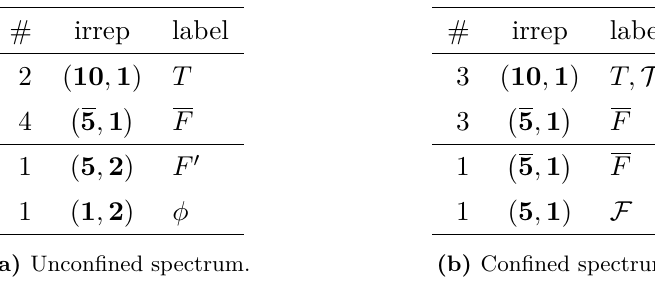
Table 2. Summary of the SU(5) × SU(2) s quantum numbers of the chiral superfield content of the 2 3